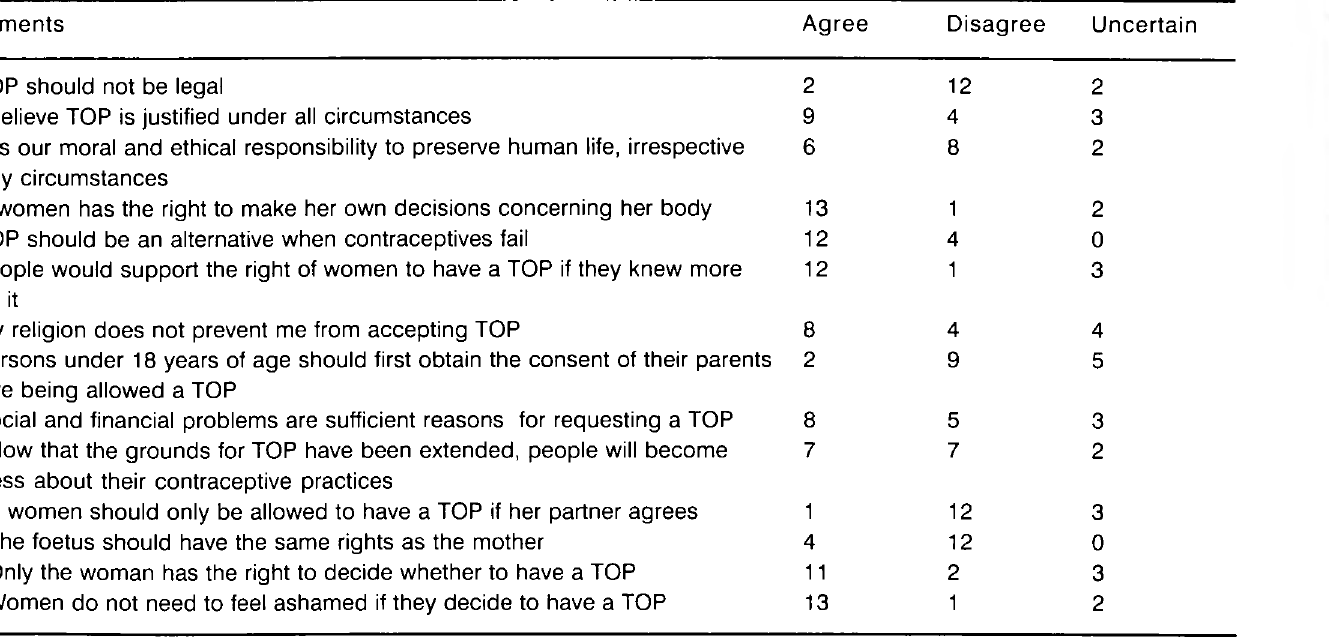
Table 5 : A ttitu d es tow ards